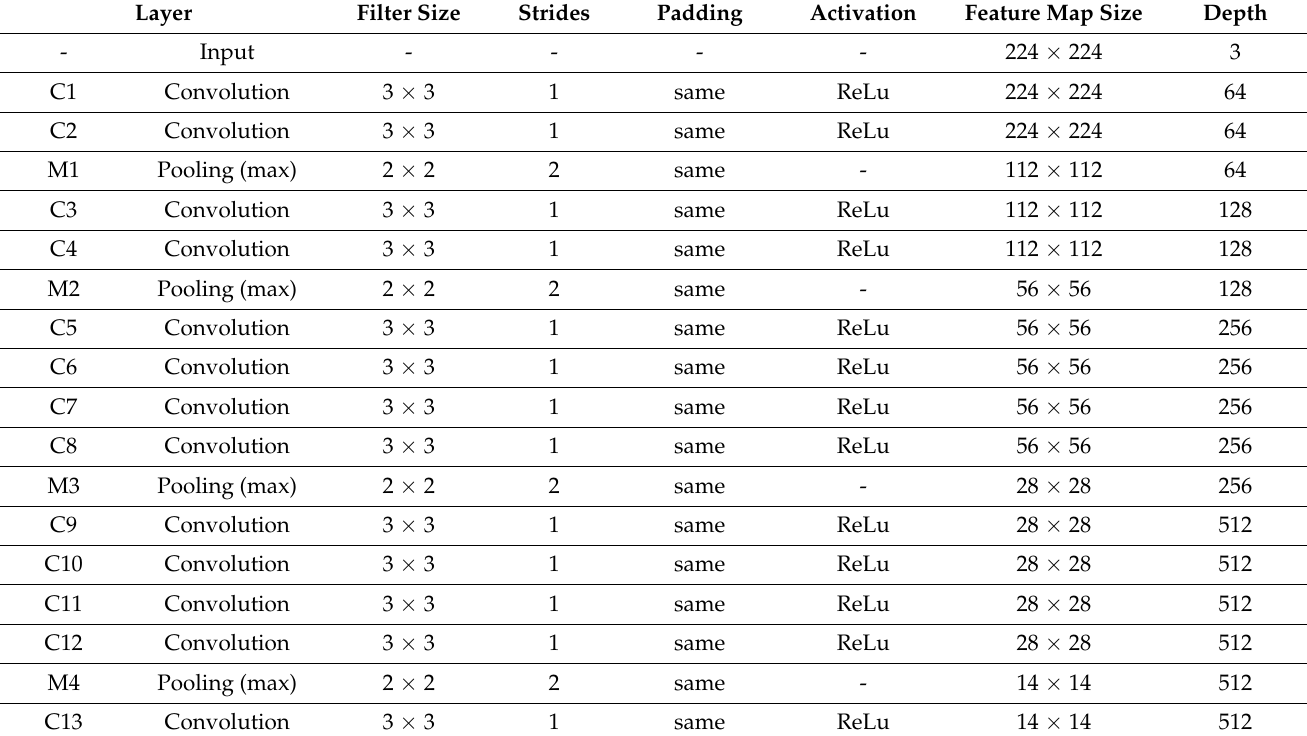
Table 1. VGGNet-19 structure details (ReLu(Rectified Linear Unit)).